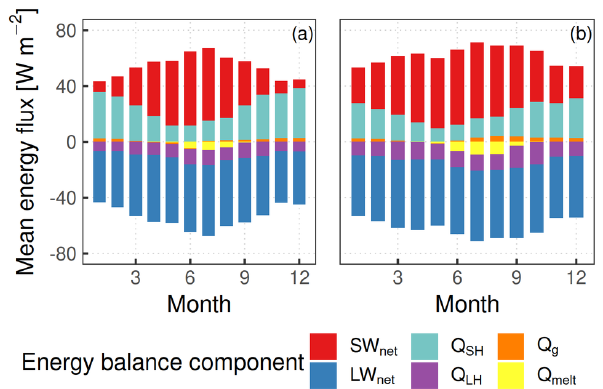
Figure 9. Mean (2003–2018) monthly distribution of modeled en- ergy balance components at (a) SK and (b) ZS. A 20m grid and 1h time step are shown. Distribution of fluxes at SP (not shown) is intermediate between the two.